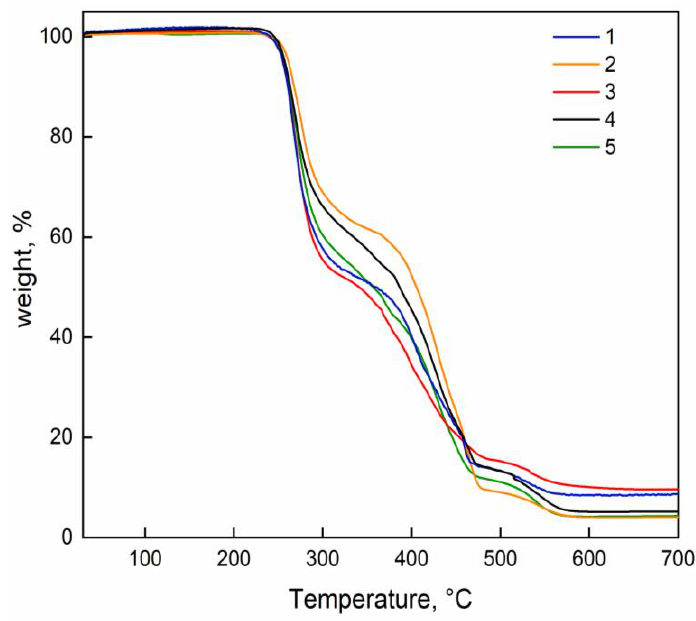
Figure 6. Thermogravimetric curves for all the samples in air atmosphere.